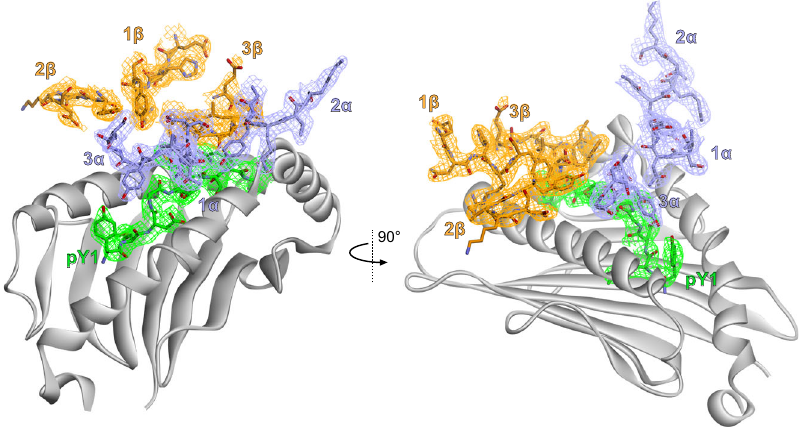
Fig. 1 | Electron density for key regions of the TIL1383I complex. Densities are froma2F o -F c compositeOMITmapcontouredat1 σ ,highlightingtheTIL1383ICDR